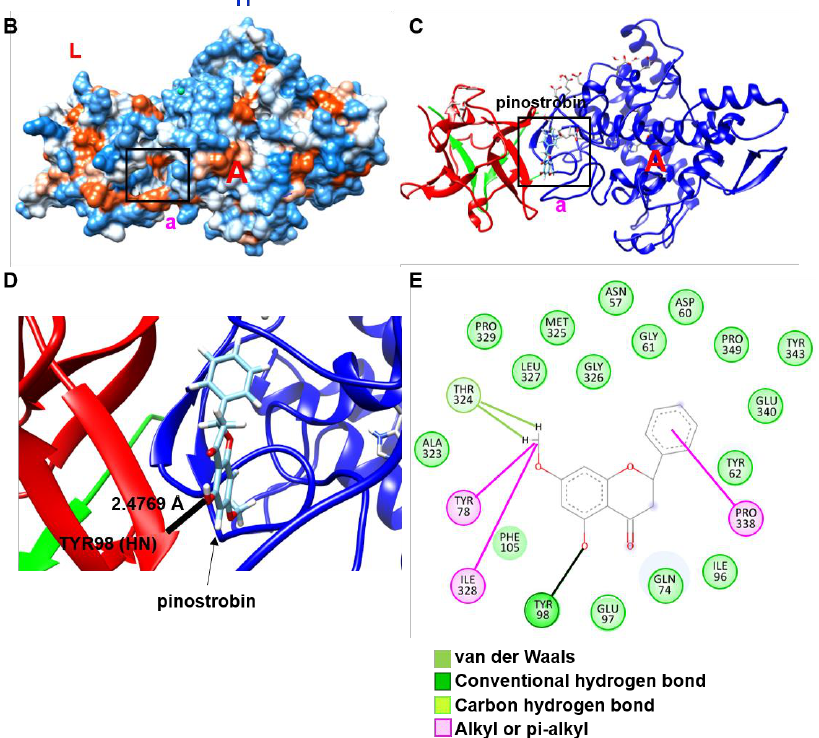
Figure 2. Pinostrobin non-competitively binds to mushroom tyrosinase (PDB ID: 2Y9X). ( A ) A total of 36 binding clusters of pinostrobin to mushroom tyrosinase were obtained from SwissDock. a, binding site for clusters 0, 1, 4, 8, 13, 17, 20, 21, 22, 23, 24, 27, 28, 30, and 34; b, binding site for clusters 2, 6, 9, 14, 18, 19, 31, and 33; c, binding site for clusters 7, 11, 25, 26, 32; d, binding site for clusters 12, 15, and 29; e, binding site for clusters 5 and 16; f, binding site for cluster 10. L, light chain (lectin-like fold protein); H, heavy chain (polyphenol oxidase). ( B ) The 3D conformation and ( C ) ribbon model how molecular docking site of pinostrobin (pink ‘a’) with mushroom tyrosinase. Red ‘A’ represents an active site of mushroom tyrosinase. ( D ) Enlarged binding site of pinostrobin with mushroom tyrosinase. A black line shows a hydrogen bond between pinostrobin and mushroom tyrosinase. ( E ) The 2D interaction poses of pinostrobin with mushroom tyrosinase.